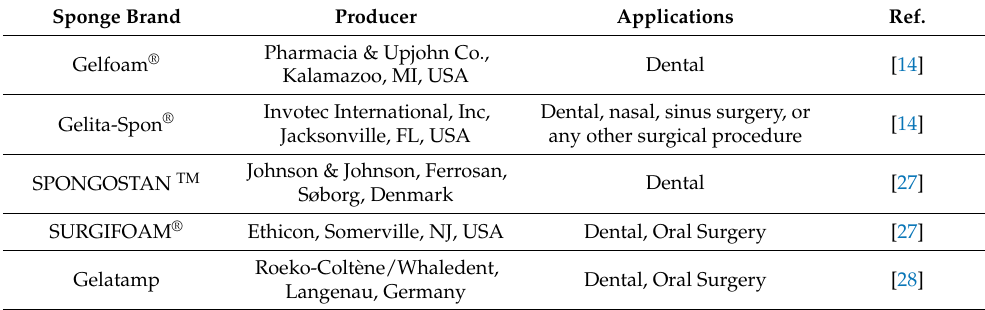
Table 1. Some marketed hemostatic gelatin-based sponges.